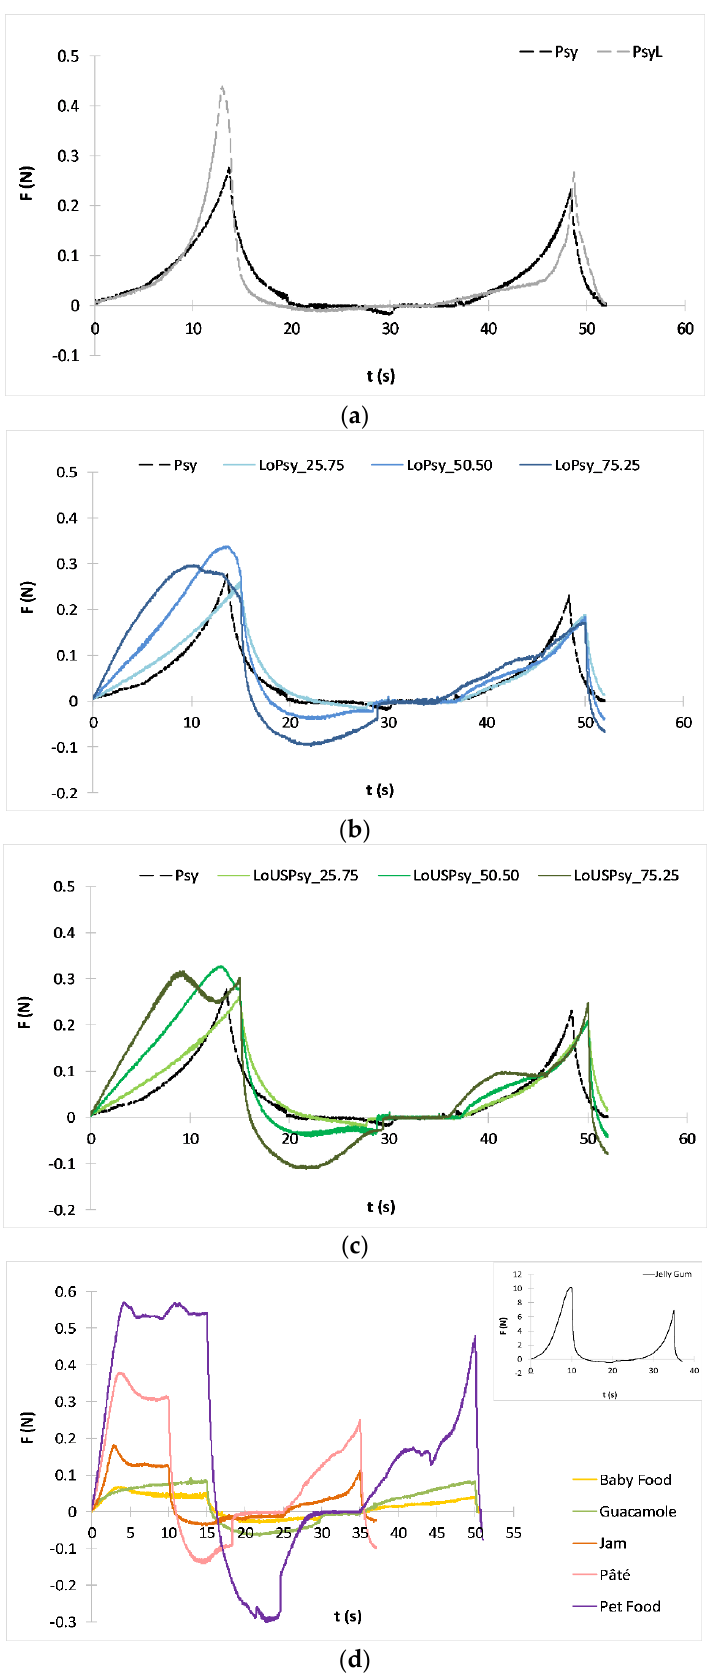
Figure 4. Texture profiles of Psy (control) and PsyL ( a ), Laminaria-Psyllium gels ( b ), Laminaria-Psyllium gels subjected to ultrasonic treatment ( c ), and commercial products ( d ). The differences in the texturograms reflect the different sizes and shapes of the commercial products.